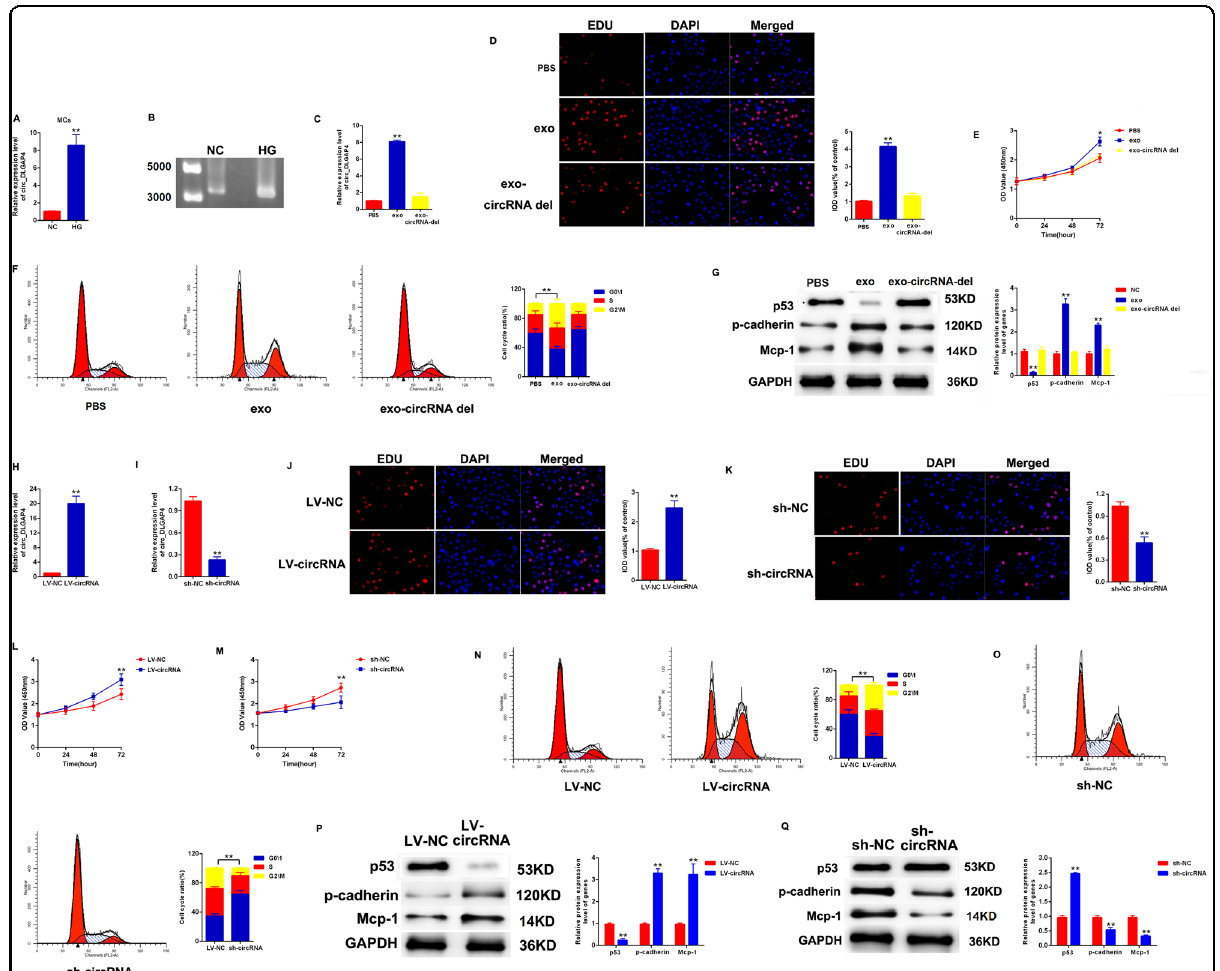
Fig. 2 Exo-circ_DLGAP4 promoted growth and fi brosis of MCs. A The expression level of circ_DLGAP4 was detected in exosomes isolated from MCs culture media treated with NC or HG. B Validation of circ_DLGAP4 using reverse transcription PCR (RT-PCR) analysis. C The expression level of circ_DLGAP4 was detected in PBS, exosomes, and exosomes-circRNA del. Exosomes were collected after si-circRNA transfection for 48 h in MCs in exosomes-circRNA del group. D , E EdU and CCK-8 were carried out to test MCs proliferation and viability. F Flow cytometric assay was used to evaluate cell cycle progression in MCs. G Western blotting was used to test p-53, p-cadherin, and Mcp-1 protein expression. H , I Ef fi ciency of LV- circ_DLGAP4 and sh-circ_DLGAP4 in MCs were detected by qPCR. J , K EdU assay was carried out to test cell proliferation. L , M Results of CCK-8 assays. N , O Cell cycle analysis using fl ow cytometric assay. P , Q Western blotting assay was used to assess p-53, p-cadherin, and Mcp-1 protein expression in MCs. Three independent experiments were conducted. Error bars stand for the mean ± SD of at least triplicate experiments; * P < 0.05, ** P <